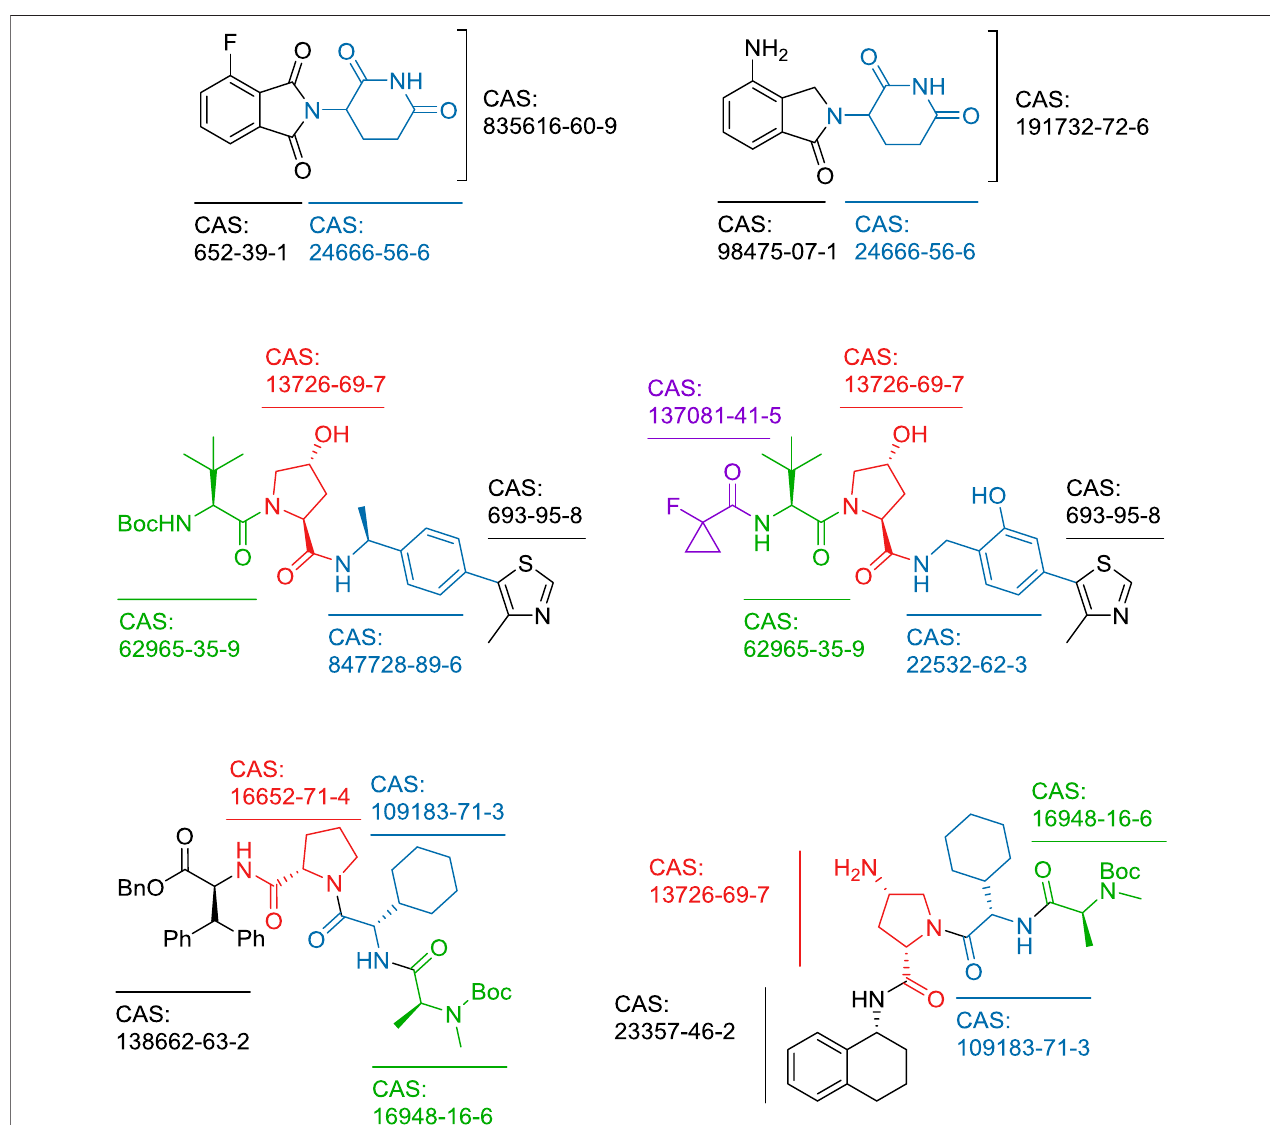
FIGURE 10 | CAS numbers of building blocks for commonly utilized CRBN, VHL, and IAP ligands.